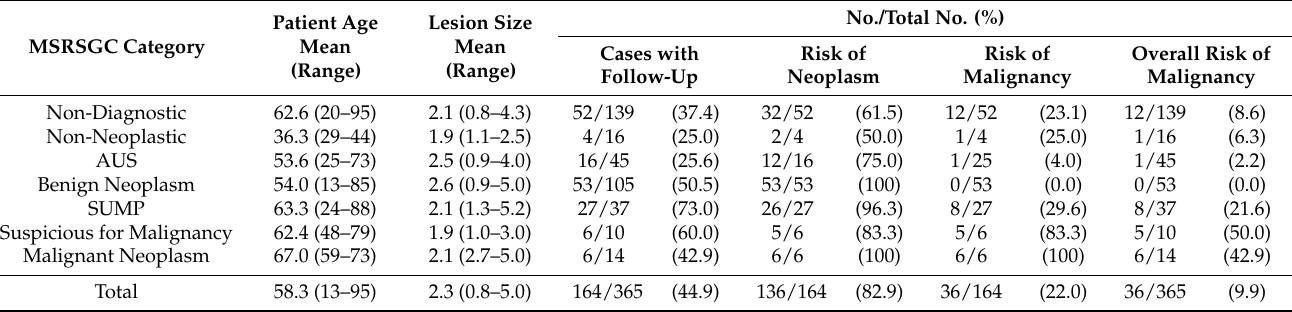
Table 1. MSRSGC: Clinical Characteristics and Risk of Malignancy.